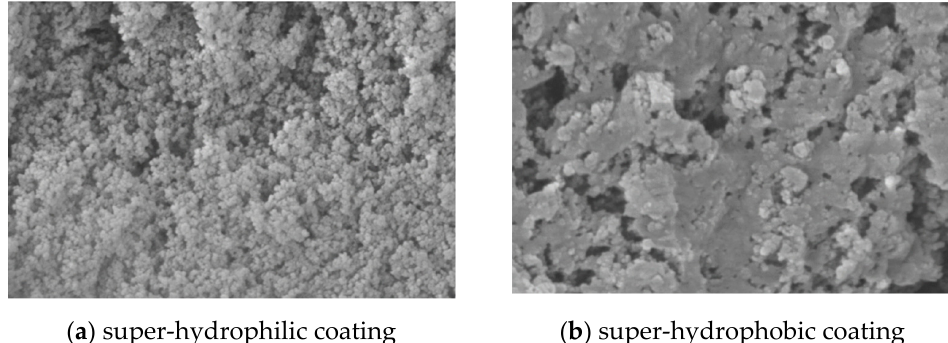
Figure 3. SEM images of surfaces with different self-cleaning coatings.